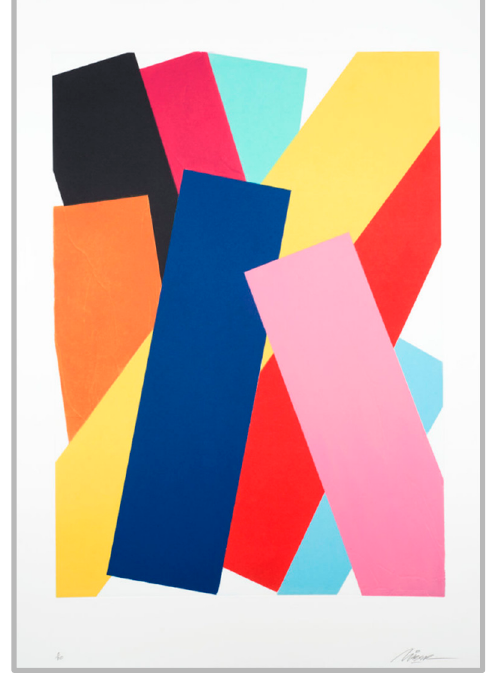
Figure 6. A sample fine art print by street artist Maser—leading to record sales in GSD.